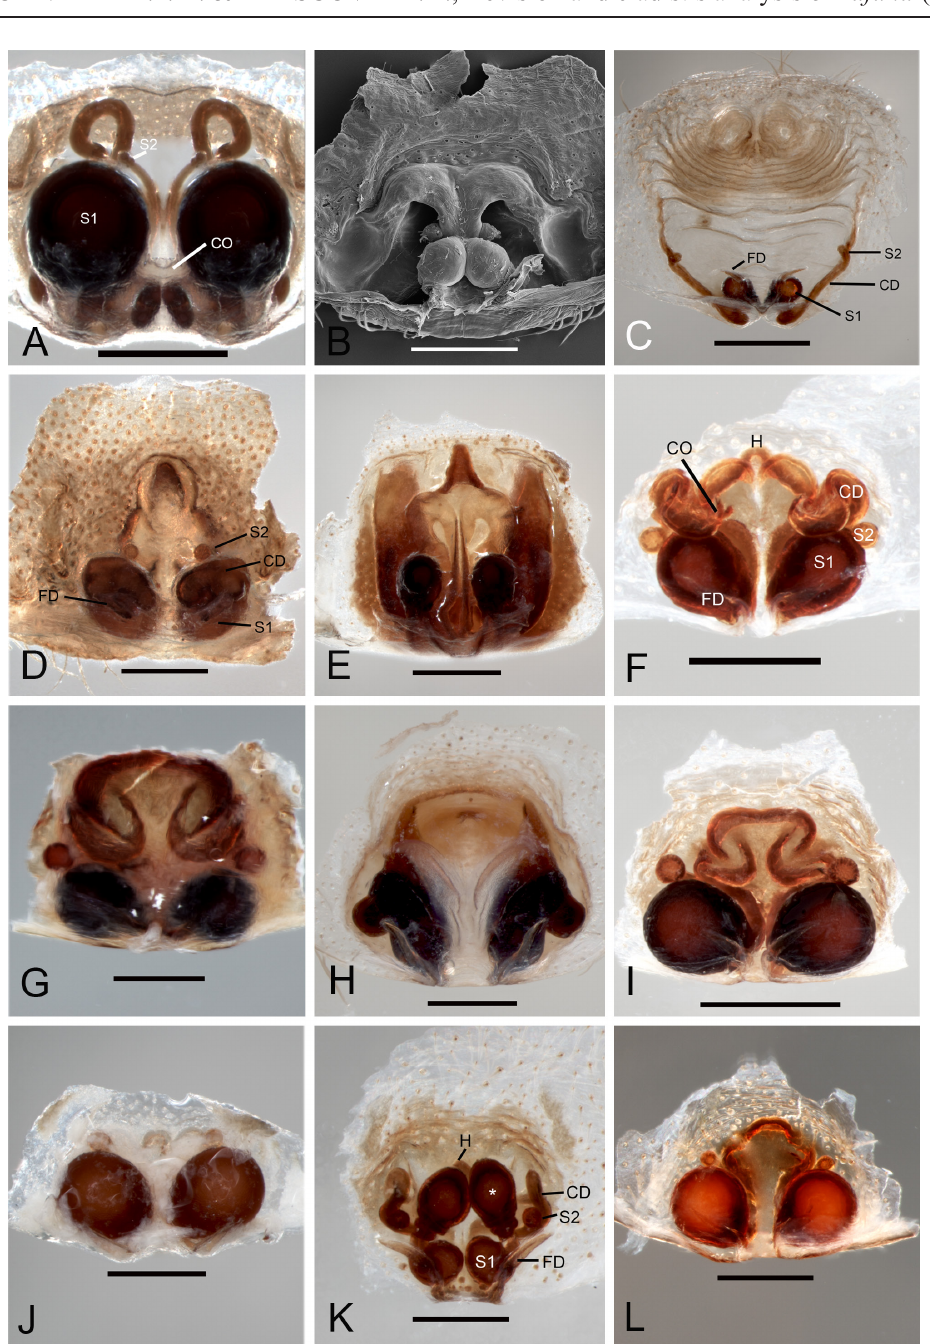
Fig. 32. Female genitalia, digested. A . Arachosia praesignis (Keyserling, 1891) (Amaurobioidinae) (IBSP 87975). B . Xiruana gracilipes (Keyserling, 1891) (Anyphaeninae) (IBSP 166120). C . Aysha prospera Keyserling, 1891 (IBSP 19783). D . Anyphaena accentuata (Walckenaer, 1802) (MCN). E . Patrera fulvastra Simon, 1903 (MCN 24208). F . Tafana riveti Simon, 1903 (MCZ). G . Tafana straminea (L. Koch, 1866) (AMNH). H . Tafana quelchi (Pocock, 1895) (IBSP 32131). I . Tafana kunturmarqa sp. nov. (ICN-Ar). J . Tafana humahuaca sp. nov. (MACN-Ar 41788). K . Tafana pastaza sp. nov. (AMNH). L . Tafana nevada sp. nov. (AMNH). Abbreviations: CD = copulatory ducts; CO = copulatory opening; FD = fertilization ducts; H = hood; S1 = primary spermathecae; S2 = secondary spermathecae. Asterisks to globose membranous extension of proximal copulatory ducts. Scale bars: A–B, D–I, K–L = 0.25 mm; C = 0.3 mm; J = 0.5